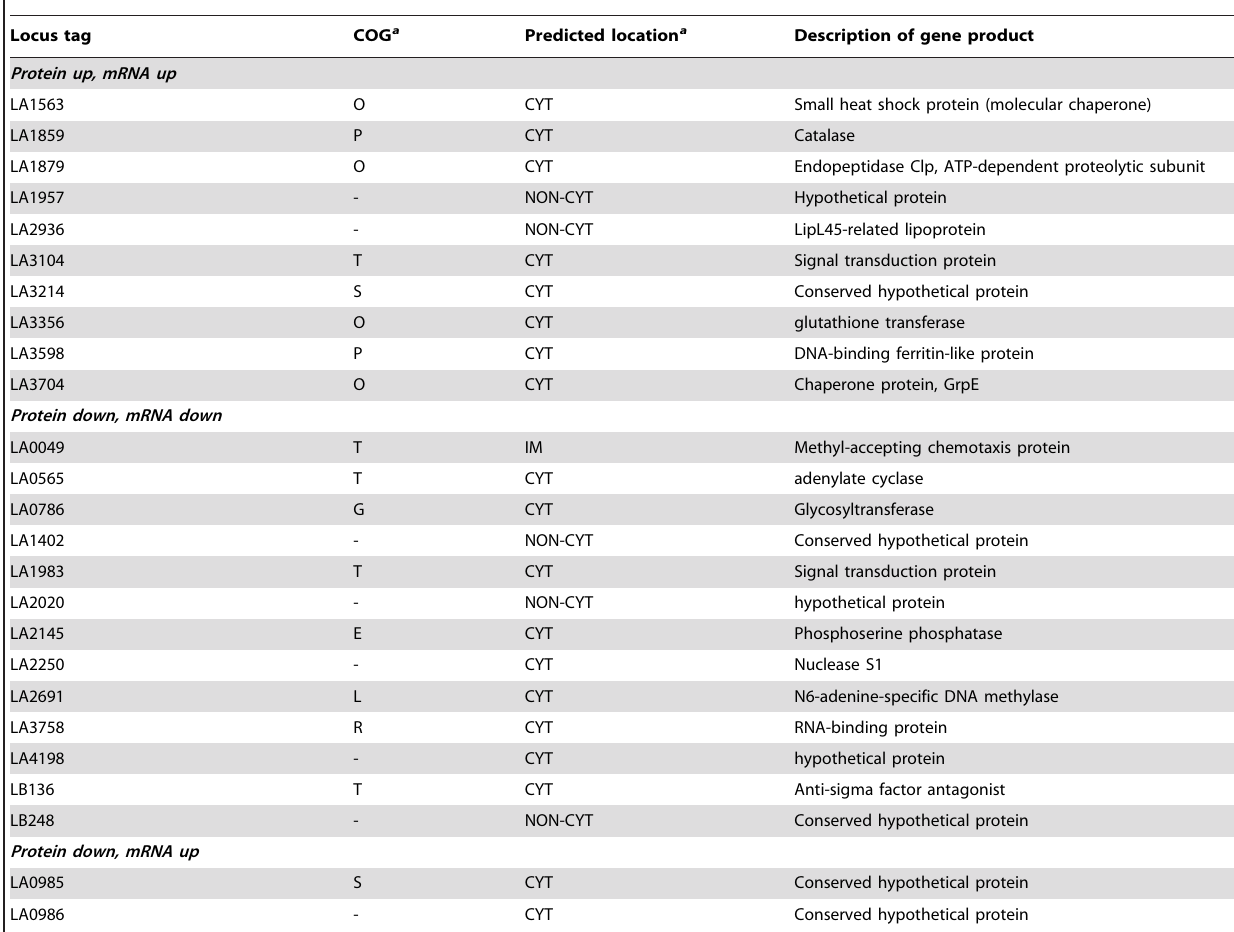
Table 4. Comparison of proteins and transcripts which were differentially